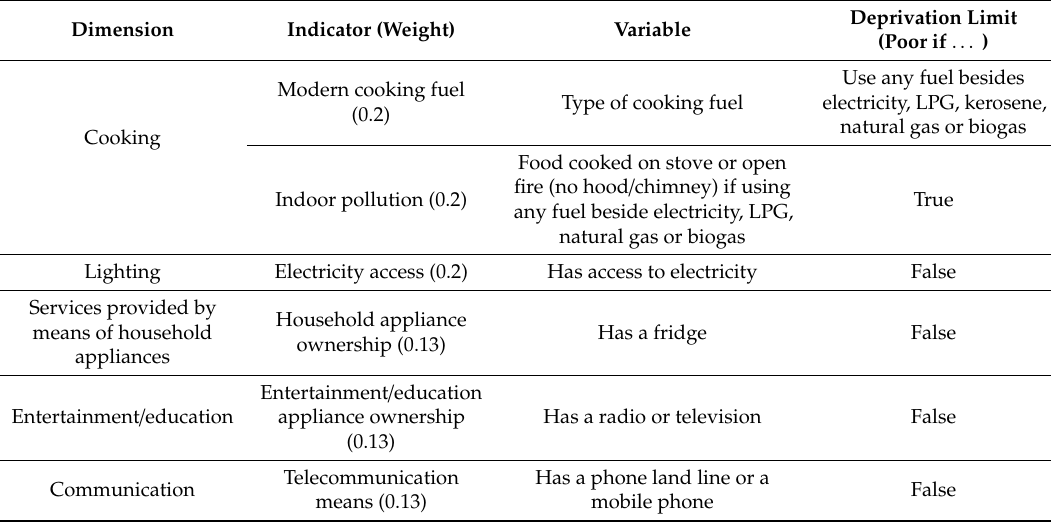
Table 4. Dimensions and variables including their weight (in parenthesis) for the Multidimensional Energy Poverty Index ( MEPI )